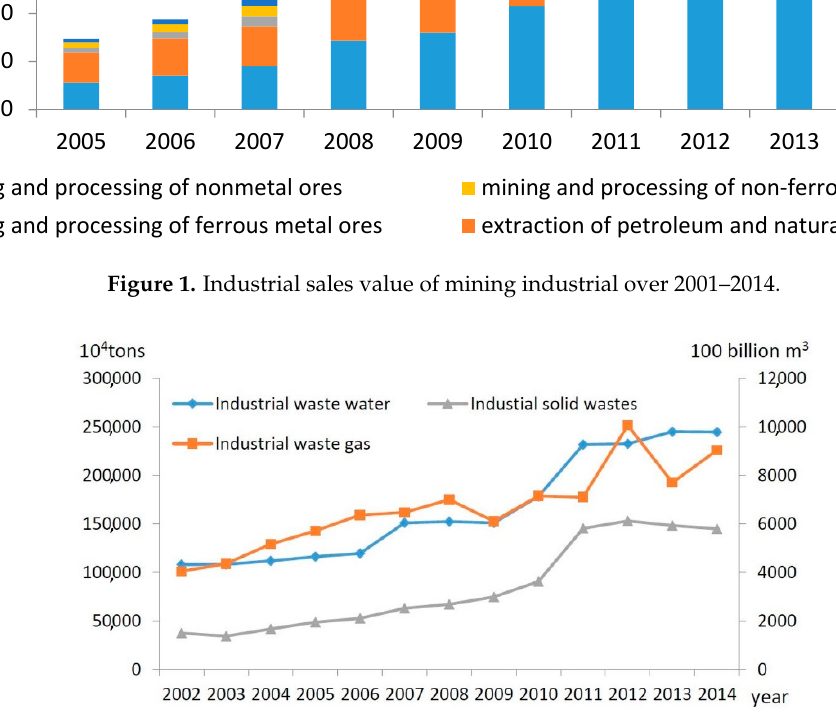
Figure 2. Three wastes emissions over 2001–2014.